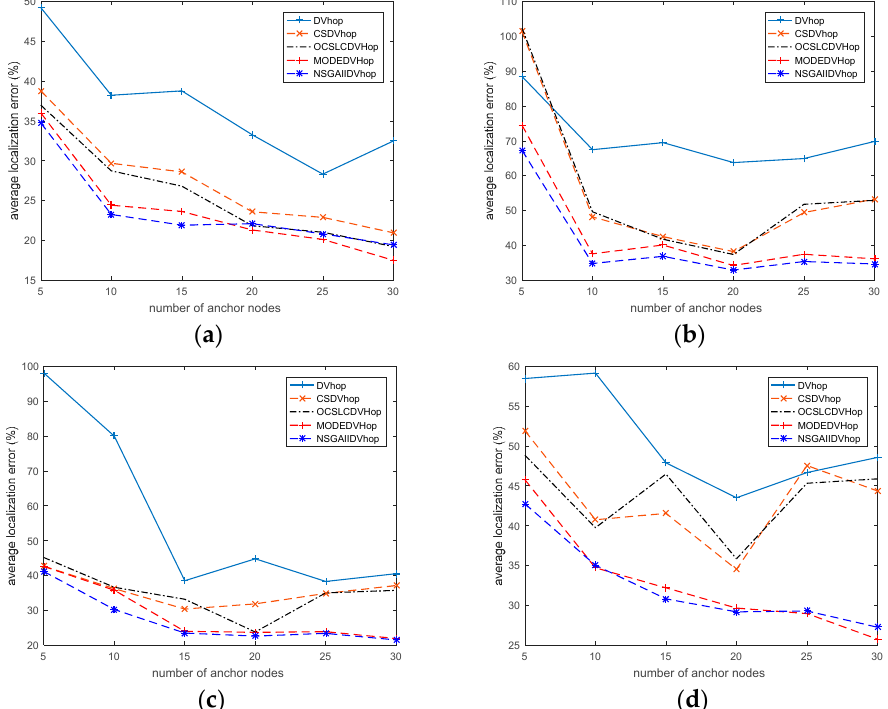
Figure 11. The ALE of four network topologies in different number of beacon nodes. ( a ) The random topology; ( b ) The C-shaped random topology; ( c ) The O-shaped random topology; ( d ) The X-shaped random topology.